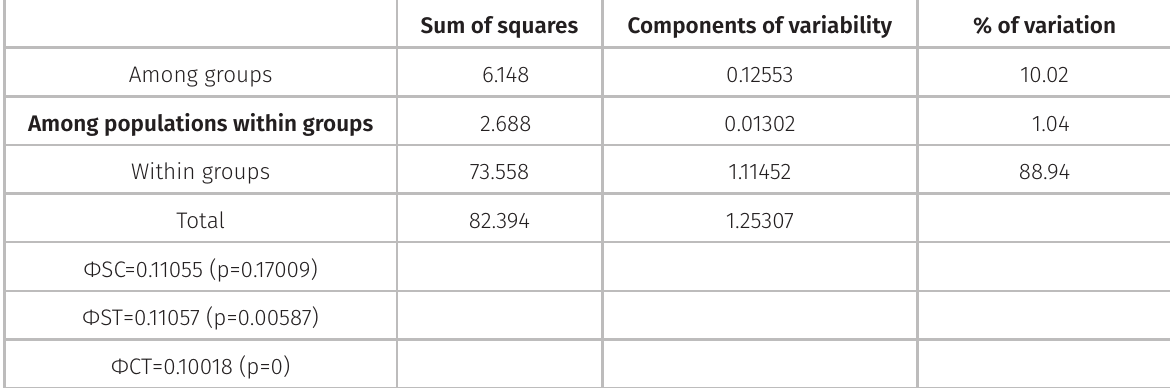
Table II. Results of the Analysis of Molecular Variance (AMOVA), considering the groups of Antilophia galeata populations present in the gallery forests of the five principal hydrographic basins of the Cerrado domain and the global fixation index (ΦST)